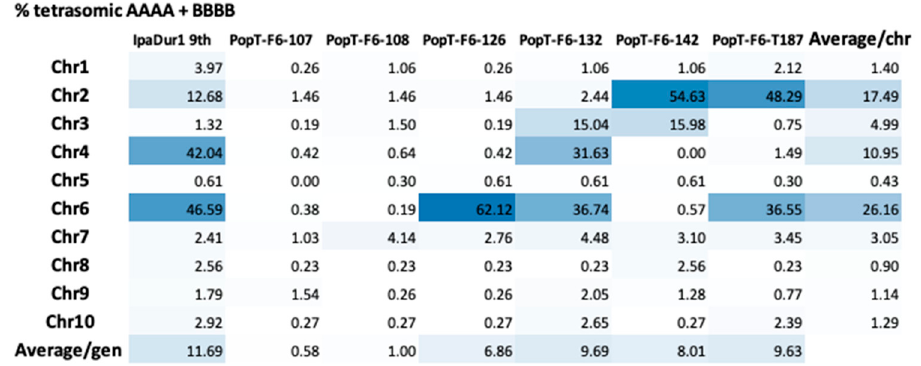
Figure 6. Heatmap showing the percentage of homeologous recombination on all chromosomes of all individuals. Note that the chromosomes with highest recombination rates are Chr6 (average 26.16%), Chr2 (17.49%), and Chr4 (10.95%).